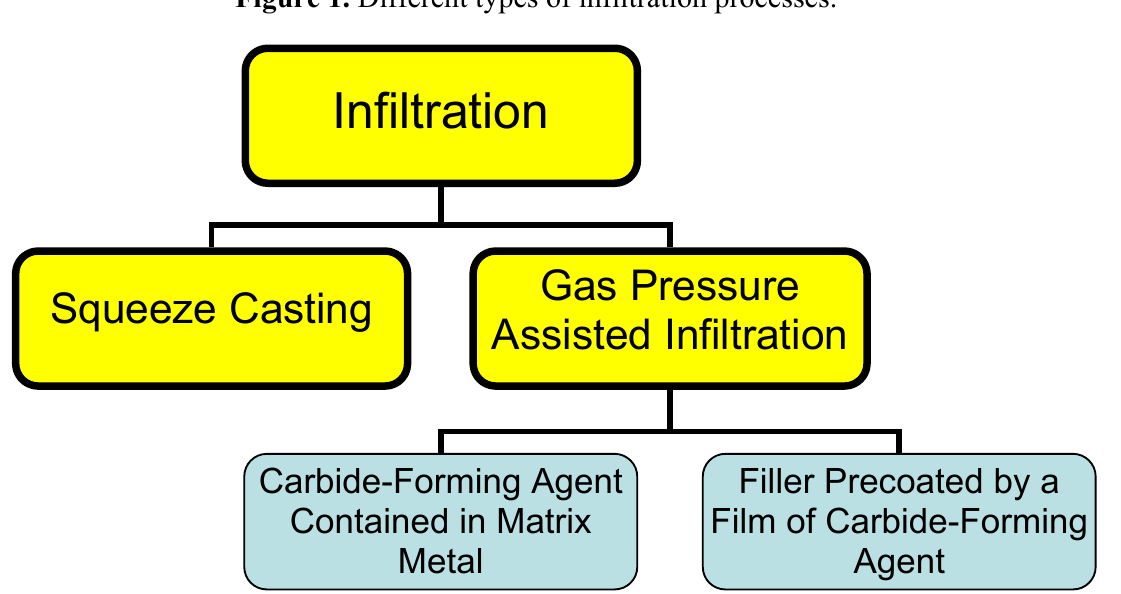
Figure 1. Different types of infiltration